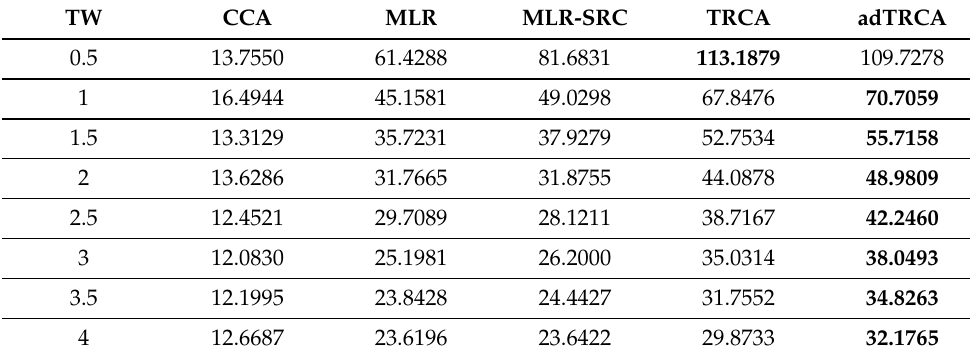
Table 3. ITR on EPOC dataset—14